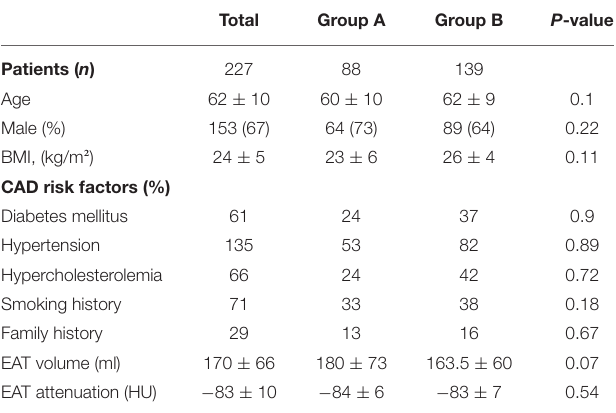
TABLE 1 | The patient characteristics and general epicardial adipose tissue (EAT) parameters in different groups.